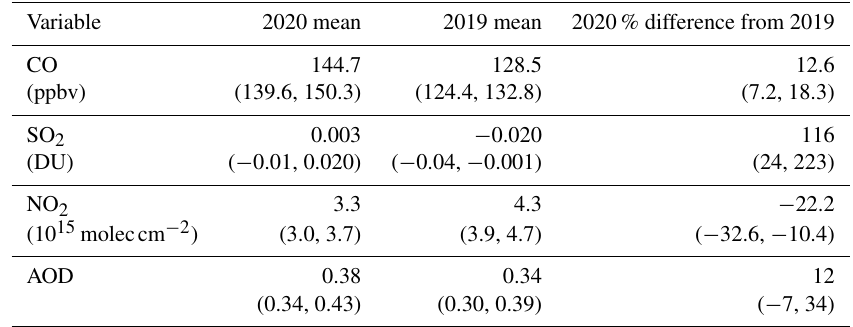
Table 2. Same as Table 1 but for southern China.